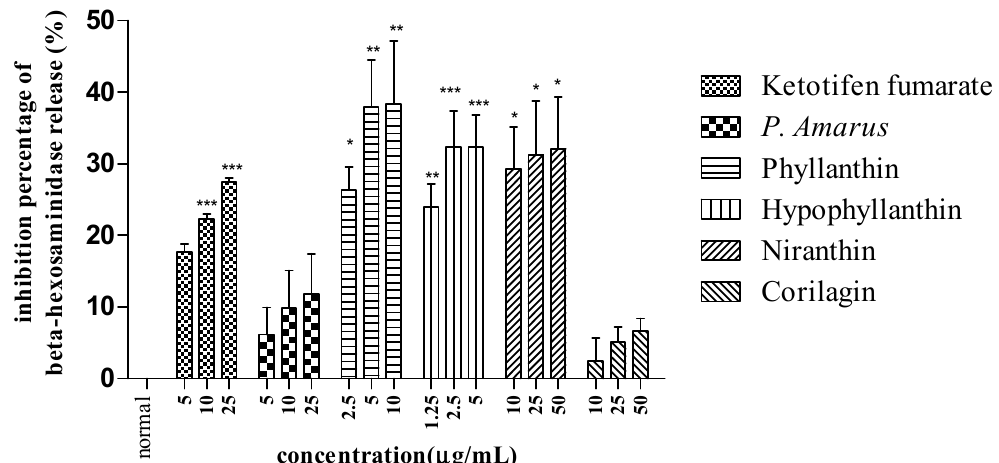
Figure 5. Inhibitory activity of P. amarus extract and its compounds towards beta-hexosaminidase release. Data are presented as mean ± SEM ( n = 3) with significant value of * p < 0.05, ** p < 0.01, *** p < 0.001 as compared to normal.